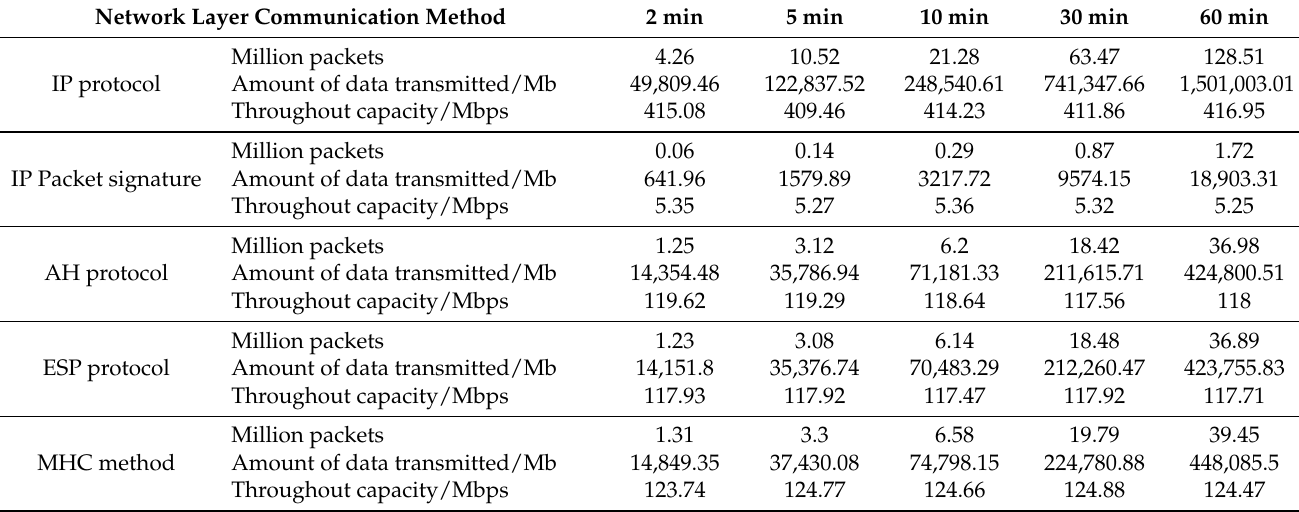
Table 3. Test results of transmission efficiency of five communication